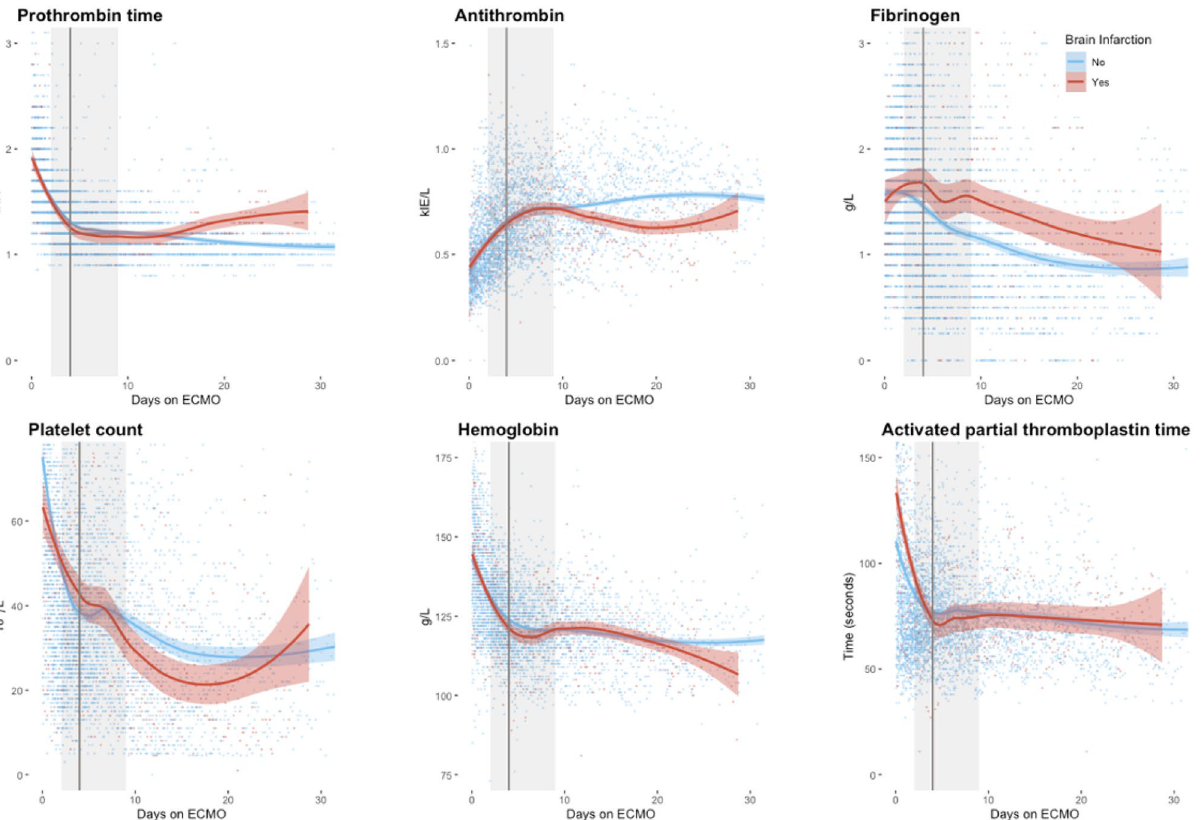
Figure 3. Longitudinal laboratory data. Coagulation assessment during ECMO support stratified by the presence or absence of a brain infarction. Locally weighted scatterplot smoothing curves are displayed, and the shaded area depicts their 95% confidence intervals. The vertical line represents median time to brain infarction, the shaded area represents the interquartile